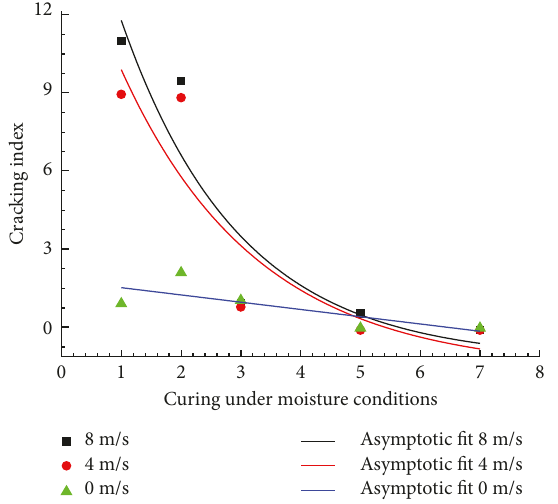
Figure 9: The relationship between cracking index and initial drying